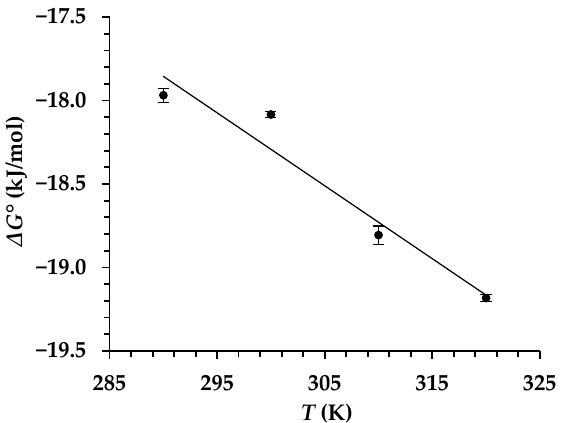
Figure 6. Thermodynamic plot for Cu(II) adsorption onto poly(acrylic acid/chestnut shell pigment) (Contact time = 24 h, pH = 6, adsorbent dosage = 1 g/L).